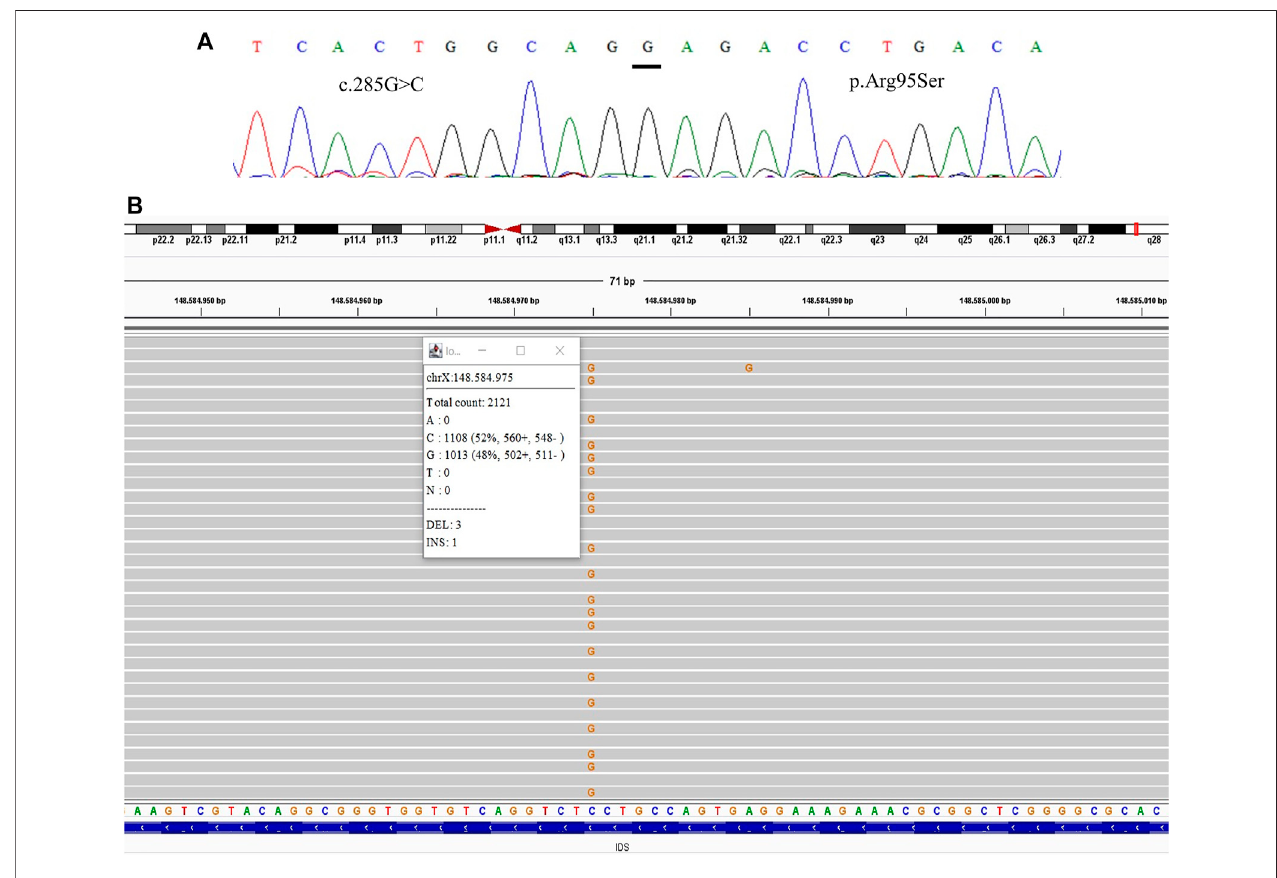
FIGURE2| ComparativeresultsofsangersequencingandNext-generationsequencingatthemutationlocusc.285G > C(p.Arg95Ser) (A) Sangersequencing (B) Next-generation sequencing showing the coverage of the locus of the mutation, presenting the mutation at a frequency of 48%.